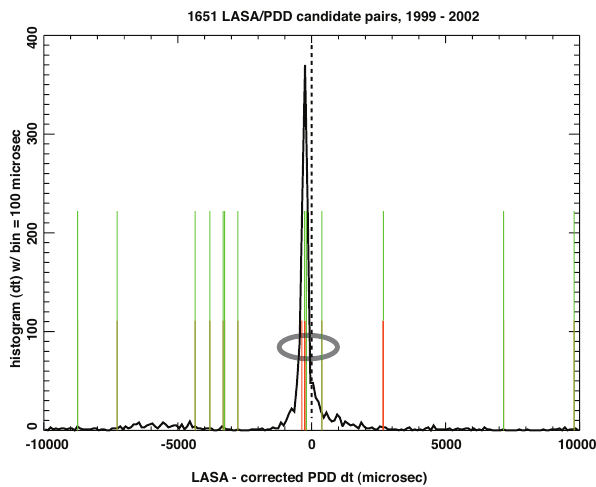
Fig. 1. Histogram of time difference of LASA sferic, minus the time-of-flight-corrected PDD optical photometer trigger time. The binsize is 100µs. There are 10061 LASA sferics located within the instantaneous PDD field-of-view during PDD nighttime operation. Of these, 1651 sferics occur within ± 10ms of a PDD trigger, and their time distribution relative to the PDD trigger is shown by the black curve. This distribution peaks at − 300µs. We define “tight coincidence” to mean a sferic/PDD pair whose LASA-PDD time difference lies in the range − 800 to + 200µs, which is centered on − 300µs. Vertical green lines mark the 16 cases of an NBE sferic being within ± 10ms of a PDD trigger, and the sferic waveforms are archived. Red vertical lines indicate cases where the sferic wave- forms are not available for all of the stations. The grey ellipse marks five apparent NBE/PDD coincidences, four of them within the tight- coincidence window, and the fifth just outside that window but still meriting further